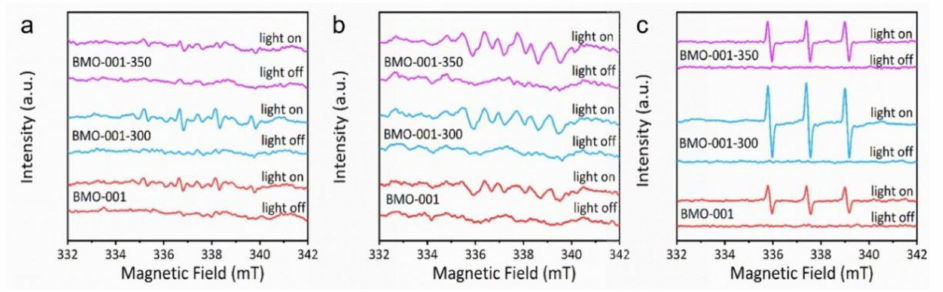
Figure 5. EPR signal of DMPO- • OH ( a ), DMPO- • O 2 − ( b ) and TEMP- 1 O 2 ( c ) for BMO-001, BMO-001- 300 and BMO-001-350 under visible light